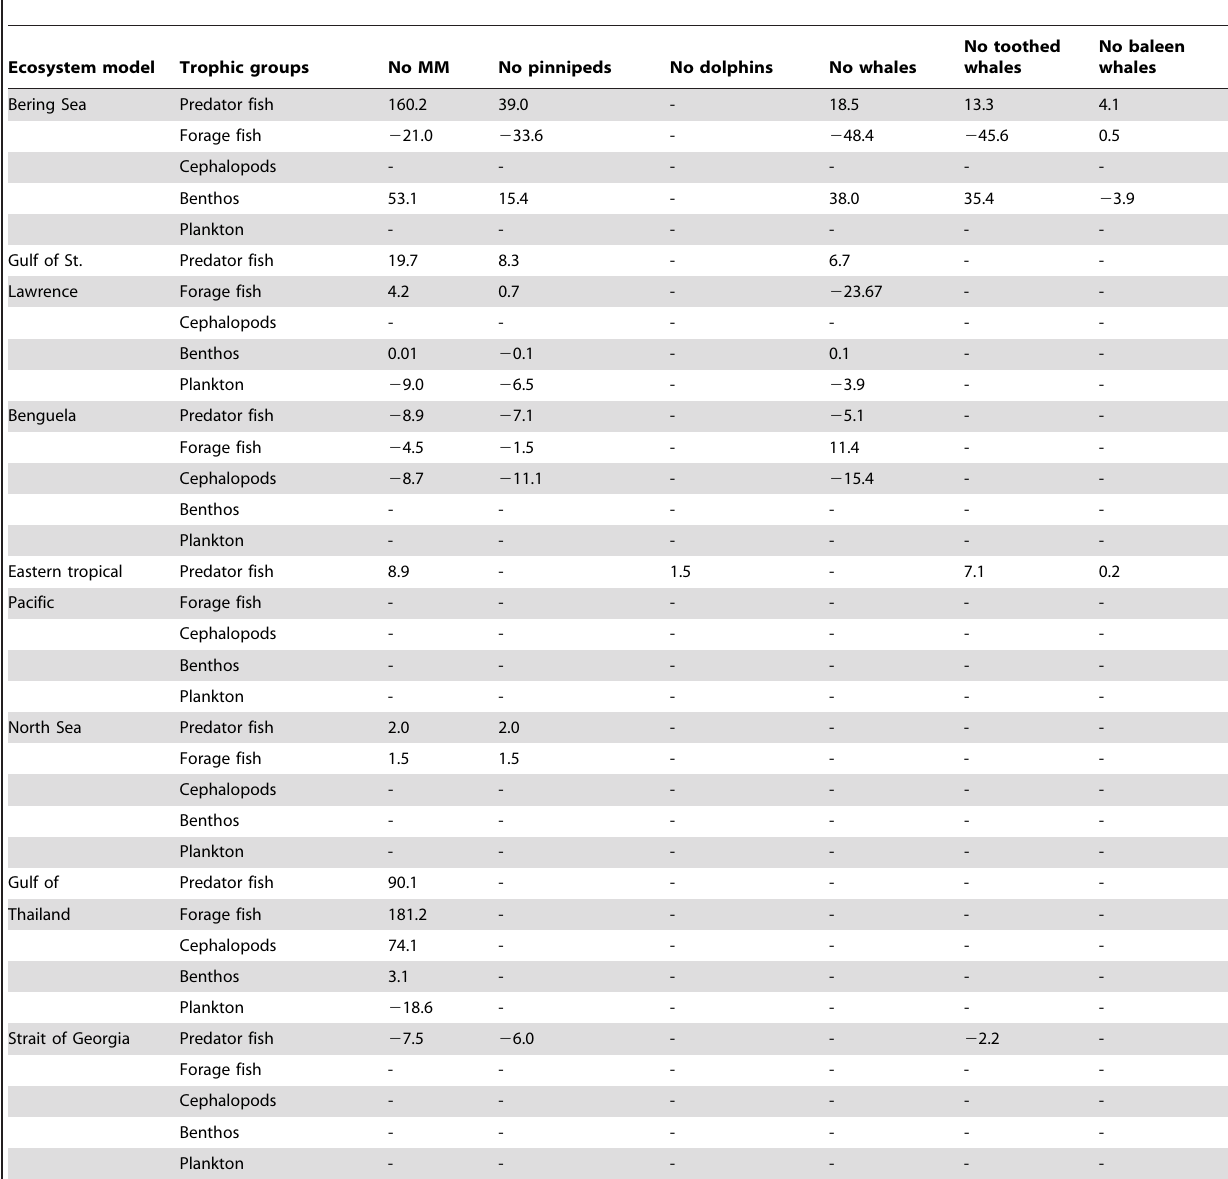
Table 4. Percentages of change in biomass for commercially important trophic groups of prey, by different marine mammals groups, in the seven study